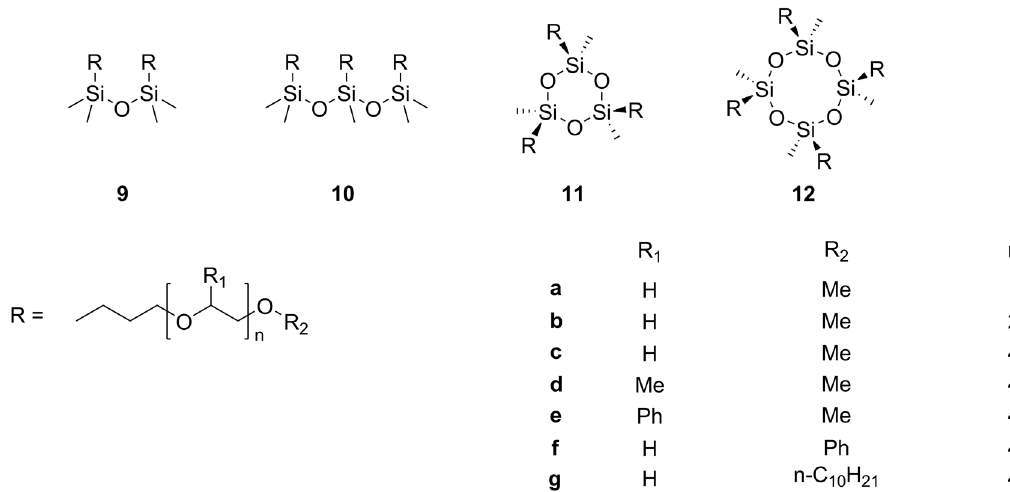
Figure 2. Structures of the studied ligands, oligosiloxane